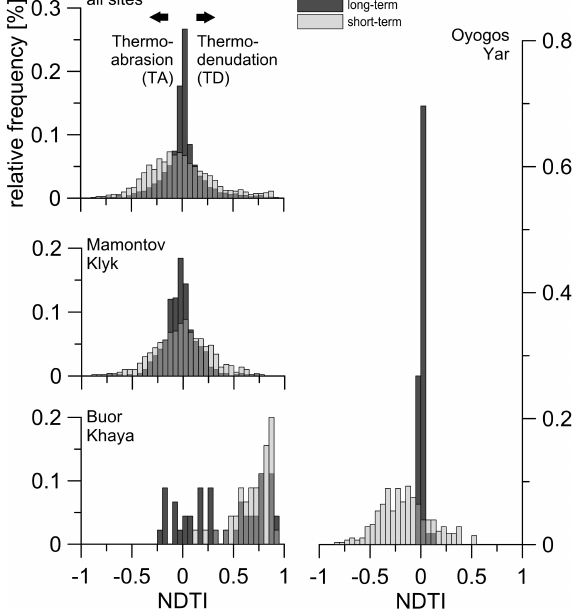
Fig. 7. Box plots of the thermo-erosion rates for long-term (39 to 43yr) and short-term measurements (last 1 to 4yr). Upper graphs: distribution of all TD (upper left) and TA (upper right) measure- ments ( n = 3635), for long- and short-term periods. Lower graphs: distribution of off all thermo-denudation (TD; lower left) and thermo-abrasion (TA, lower right) measurements from transects, for which both long- and short-term observations are available, plotted separately by study sites Mamontov Klyk, Buor Khaya, and Oyo- gos Yar. Box plots show lower and upper quartiles, medians and outliers (points), defined as erosion rates more than 1.5 times the interquartile range above or below the